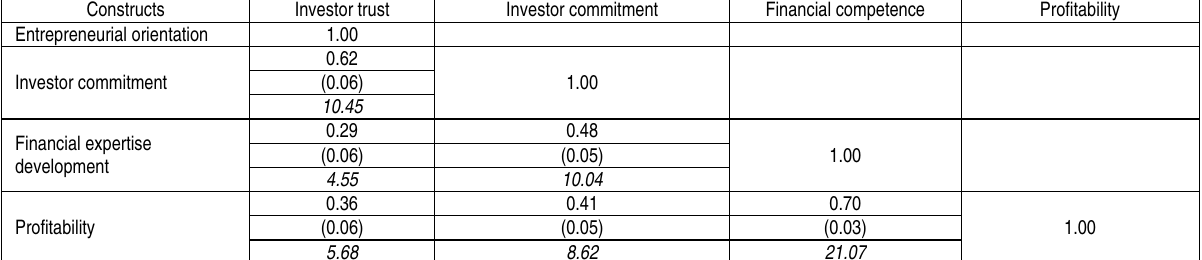
Table 3. The correlation between the constructs, the error terms (in parentheses), and t -values (in italics)